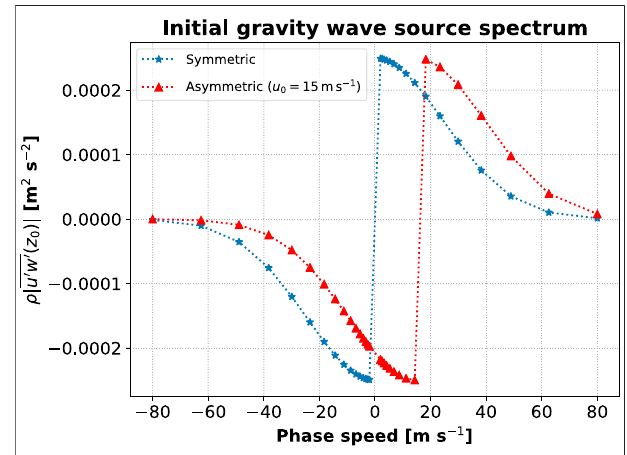
FIGURE 1 | Default gravity wave spectrum launched at the source pressure level ( p (cid:2) 100 hPa, ∼ 15 km) plotted as a function of harmonic ’ s horizontal phase speed. The blue and red curves show the symmetric and asymmetric spectra, respectively. The symmetry property of the spectrum is dependent on the variations of the wind at the source level u 0 (cid:2) u ( z 0 ) , which is assumed to be 15 m s − 1 in the fi gure for illustrative purposes. In the GCM, u 0 has spatiotemporal variability. The spectral parameters of the standard spectrum are as follows: c w (cid:2) 35 m s − 1 and u ′ w